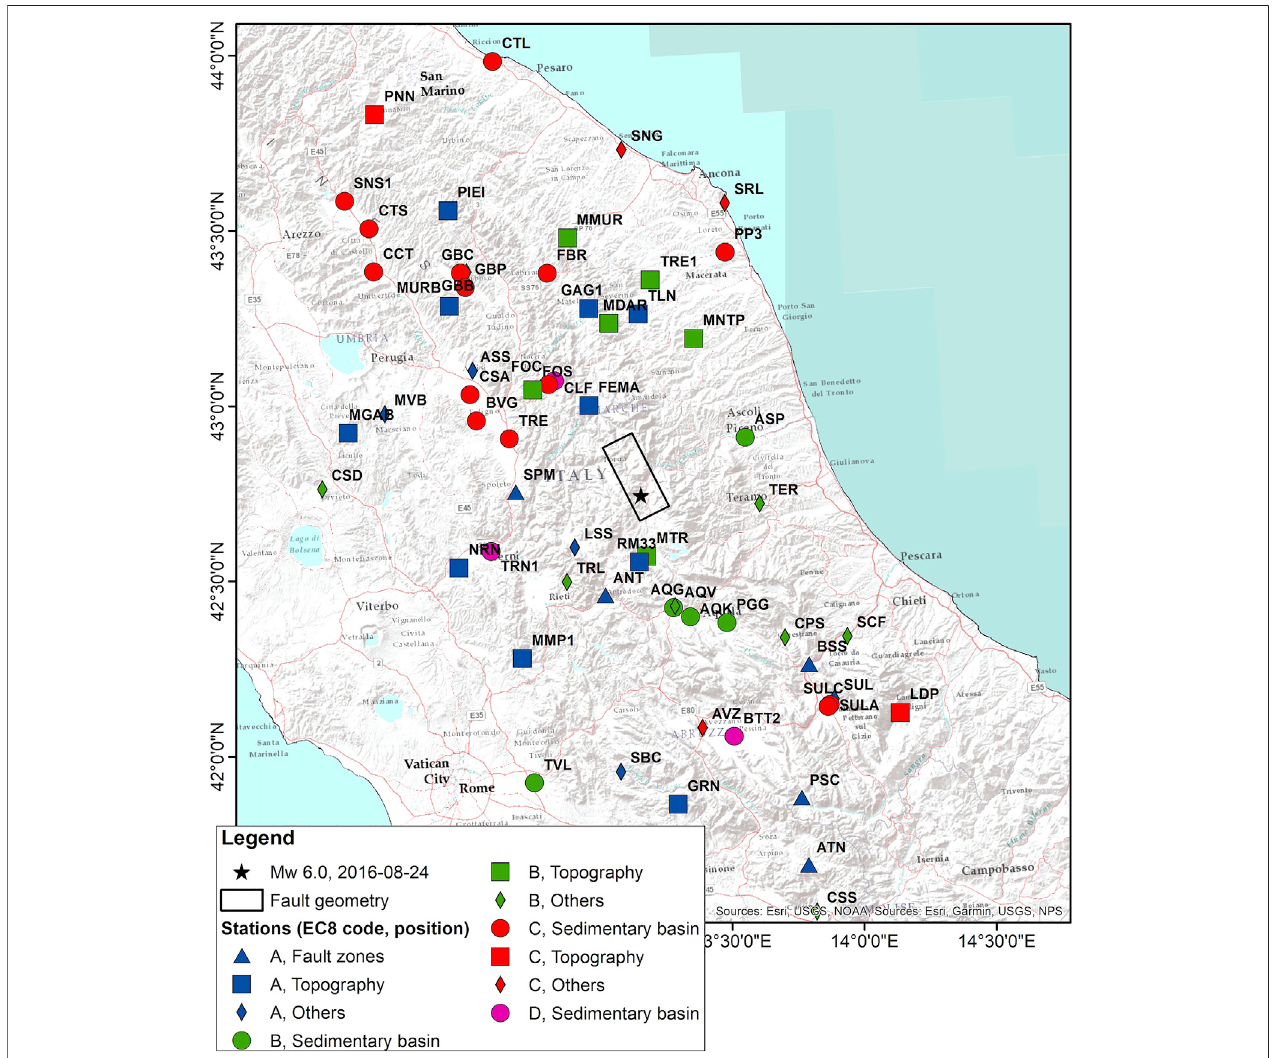
FIGURE 1 | Map showing stations considered in this study up to a distance of 150 km to the epicenter of the M w 6.0 Amatrice earthquake (black star), and lying in particularsiteconditions,suchassedimentarybasins(circle),topographicirregularities(square),faultzones(triangles).TheybelongtoRAN( “ IT ” )andRSN( “ IV ” )networks ( Table 1 ). We also add the fault surface projection of the causative fault proposed in Tinti et al. (2016). Symbol color is related to site classi fi cation according to NTC18 based on the V s30 parameter (blue = class A, green = class B, red = classes C, and pink = D).